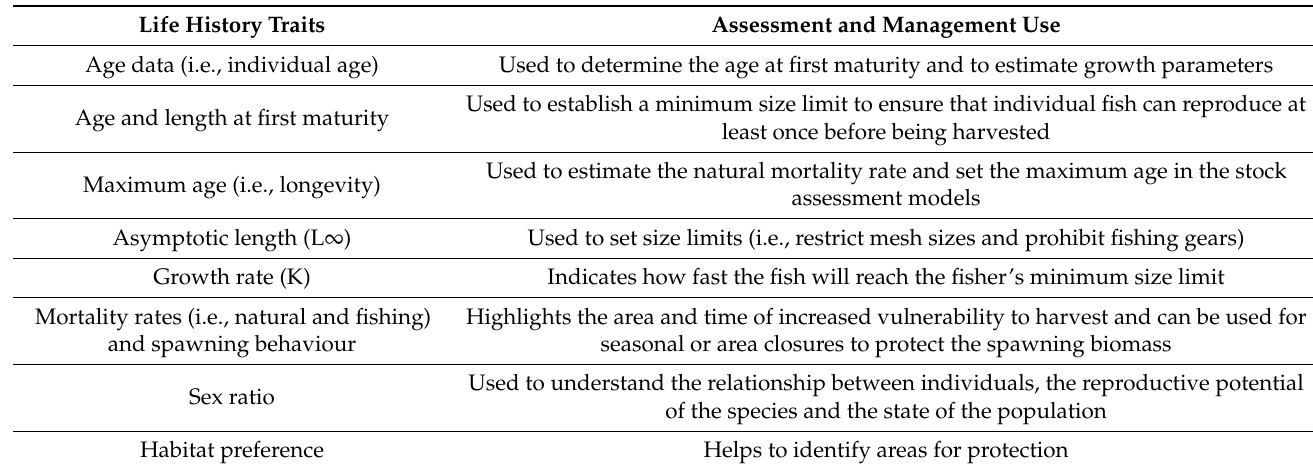
Table 1. The importance of life history traits for assessment and management